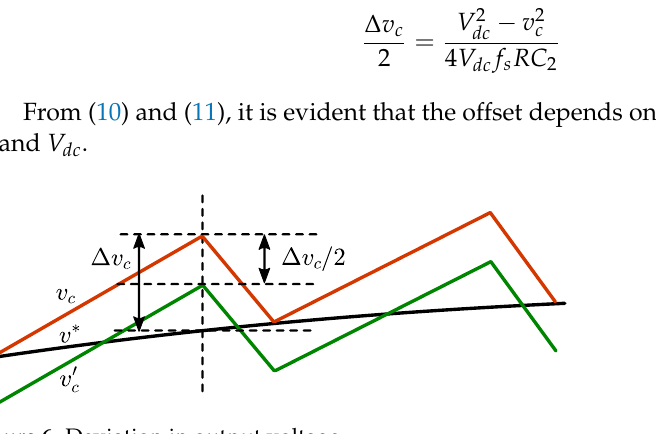
Figure 6. Deviation in output voltage.